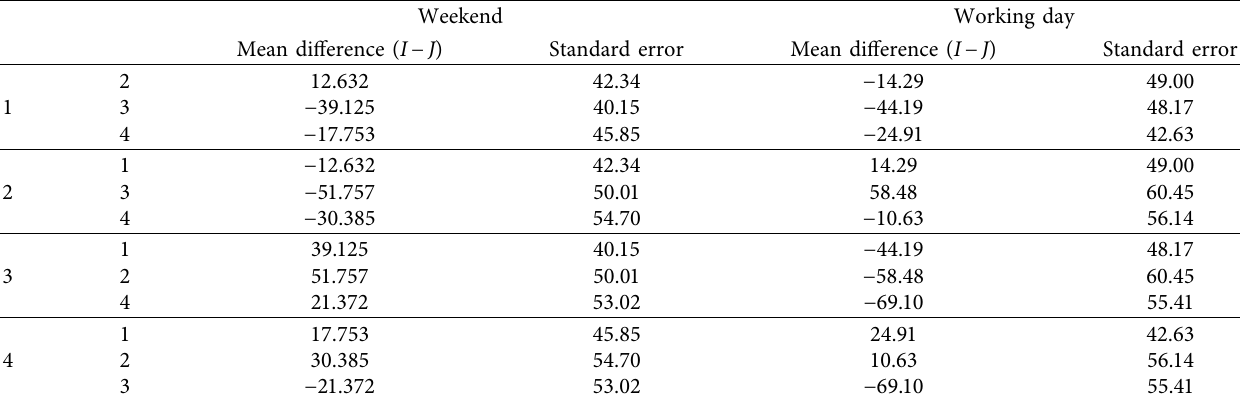
Table 4: ANOVA test of total activity duration.